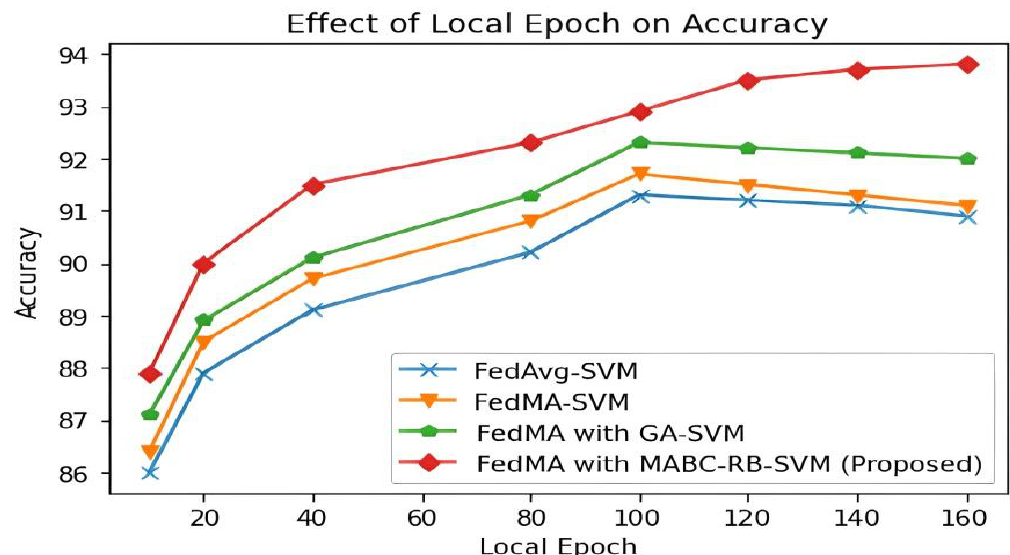
Figure 4. Comparison of the effect of local epoch on the prediction accuracy.